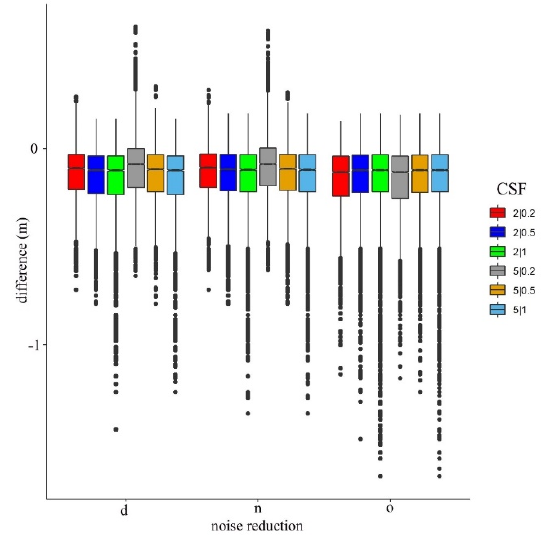
Figure 4. Difference between ground reference and the modeled values by noise filtering methods (d: surface distance-based, n: neighborhood distance-based filtering, o: original point cloud) and cloth simulation filter (CSF) settings (cloth size | threshold).